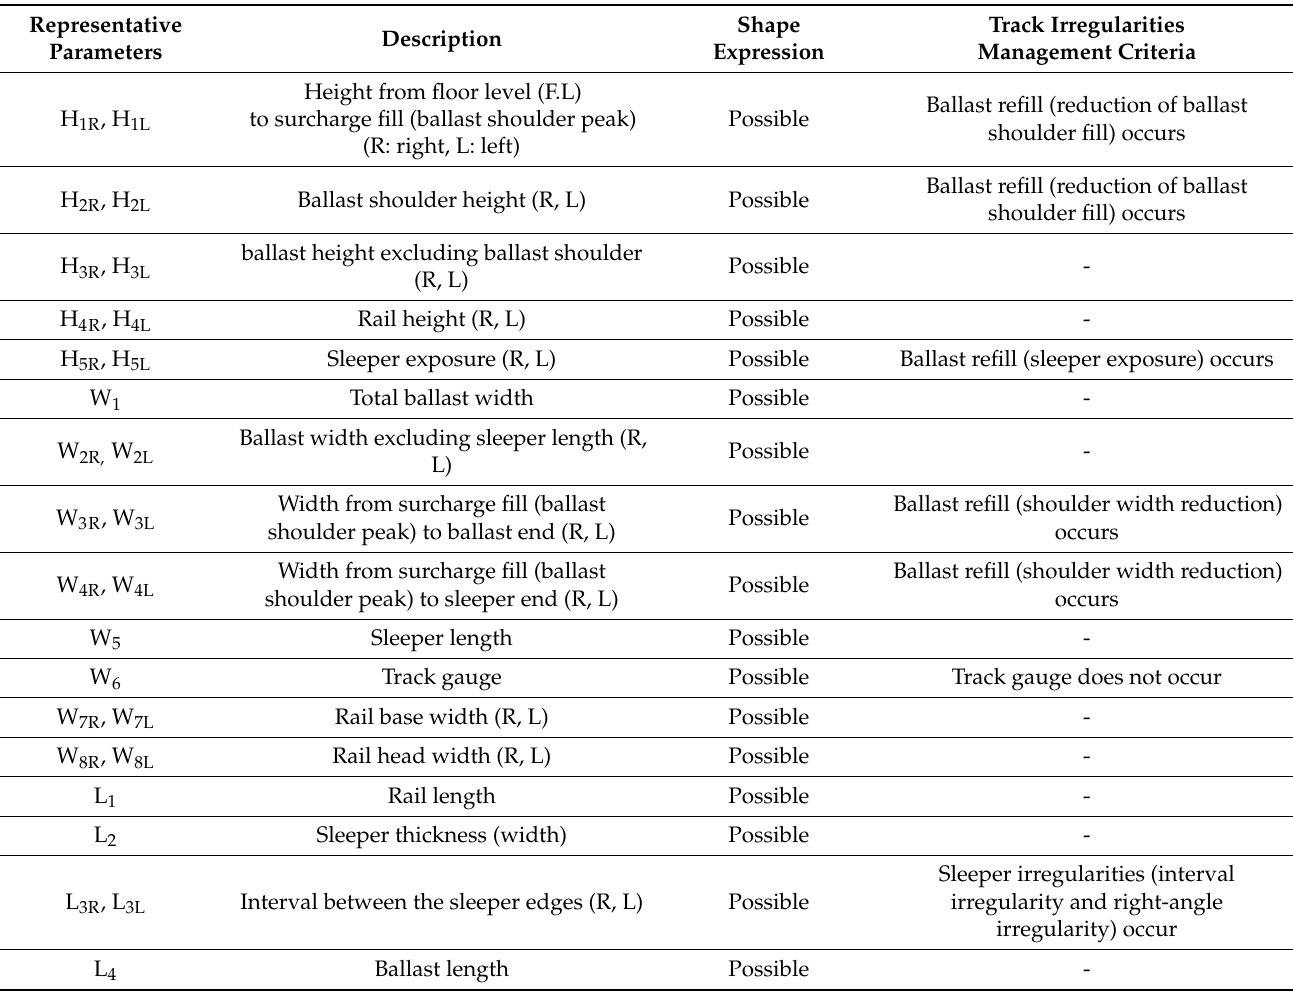
Table 2. Results of the review of possible shape expressions and damage types based on representative parameters.